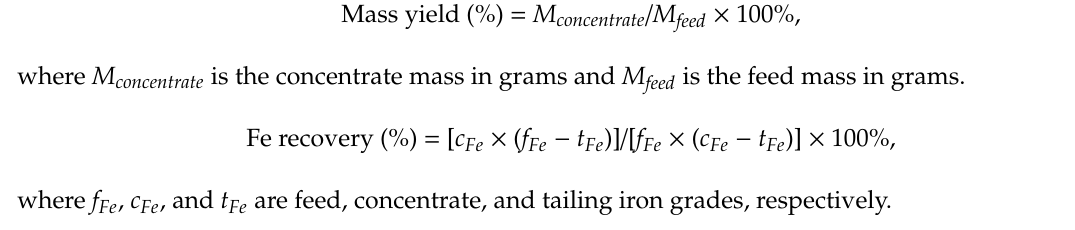
Table 1. The major elemental composition of the ore.